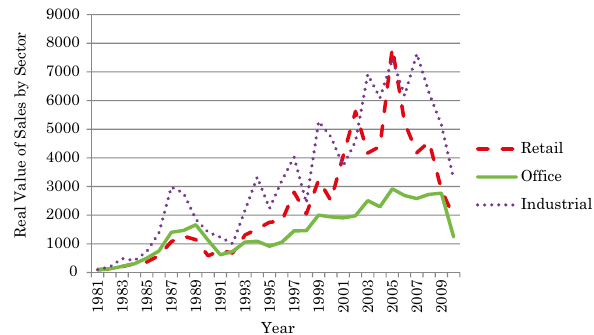
fig. 4. Indices of the annual real value of sales by property sector 1981–2010